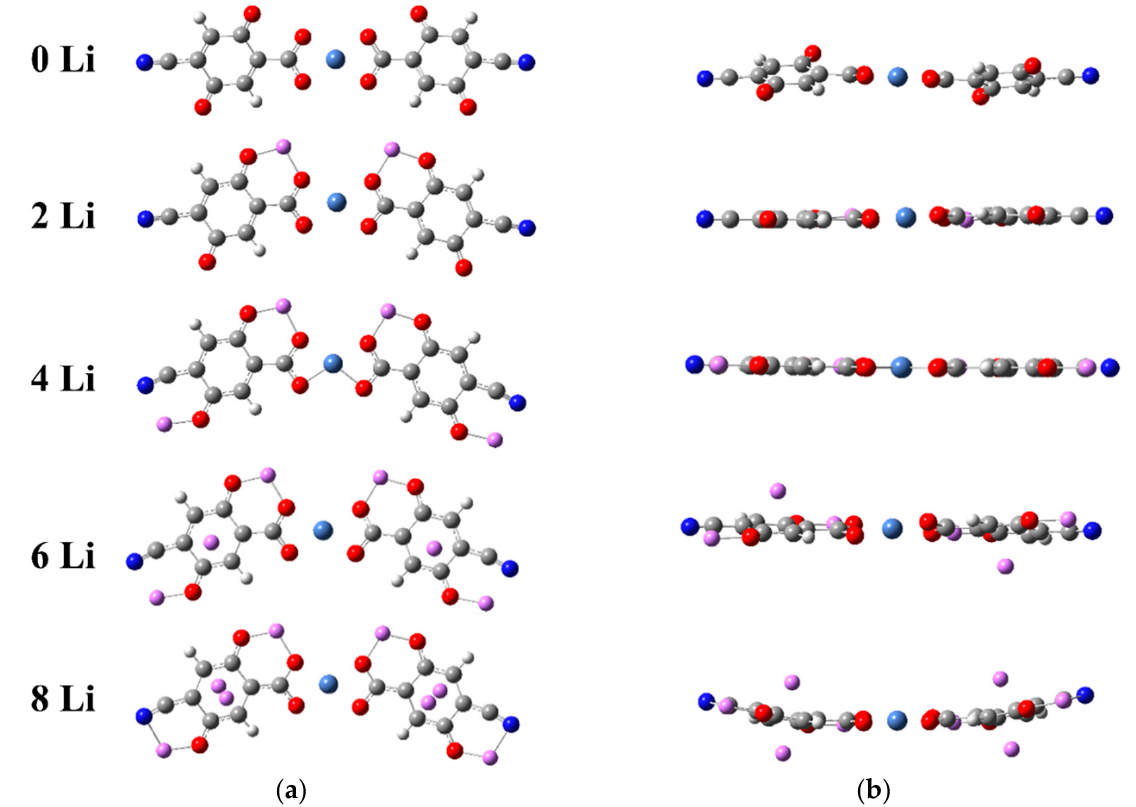
Figure 2. Stages of lithiation of Ni(II)(L1) 2 —top ( a ) and side ( b ) view of the optimized geometries. Color code: C—gray, H—white, O—red, N—deep blue, Ni—light blue, Li—pink. Table 1. Multiplicity and N-to-N length (l mol ) of Ni(II)(L1) 2 upon lithiation.